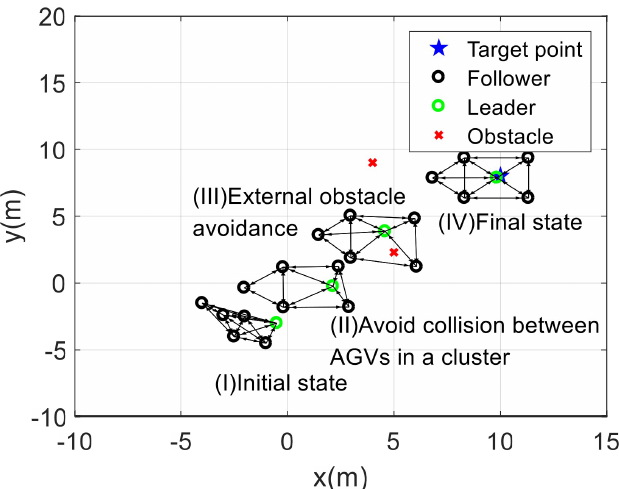
Figure 4. Movement process of a single cluster. The figure shows the formation in four cases. The four cases are: initial state, avoid collision between AGVs in a cluster, External obstacles avoidance, final